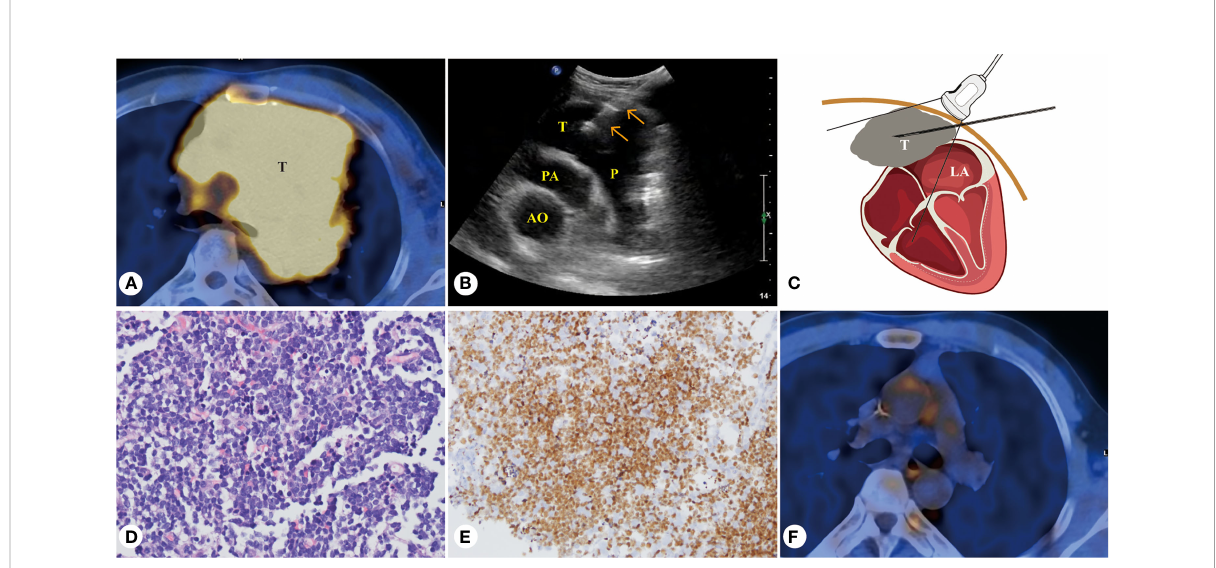
FIGURE 3 Forty-three-year-old male patient, T-cell blastoma of the heart. (A) PET/CT presentation of a mediastinal mass with a maximum SUV of 8.7 at the base of the heart and the pericardium. (B) PUS-CNB of the pericardial mass at the base of the heart from the left third intercostal space. (C) Schematic diagram of PUS-CNB. (D) The microscopic features showed diffuse patches of small- to medium-sized atypical lymphocytes (H&E, × 400). (E) Immunohistochemically, the tumor cells nuclei were strongly positive for TdT (× 200). (F) After four courses of chemotherapy, PET/CT showed that the T-cell blastoma lesion disappeared. AO, aorta; PA, pulmonary artery; P, pericardial space; T,